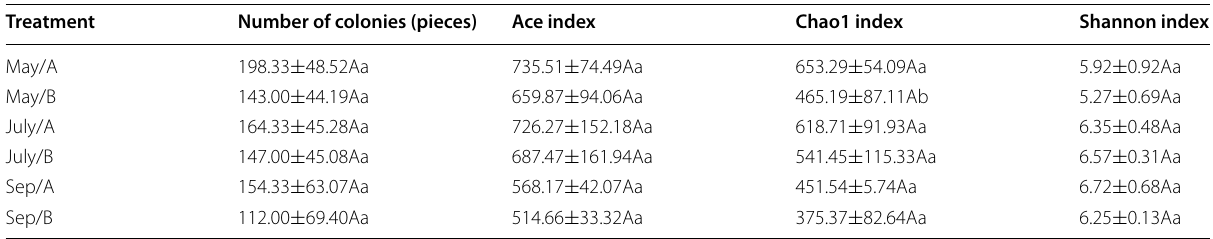
Table 2 Quantity and diversity index of the fungi community in the soil in sweet potato intercropping and monoculture in a banana